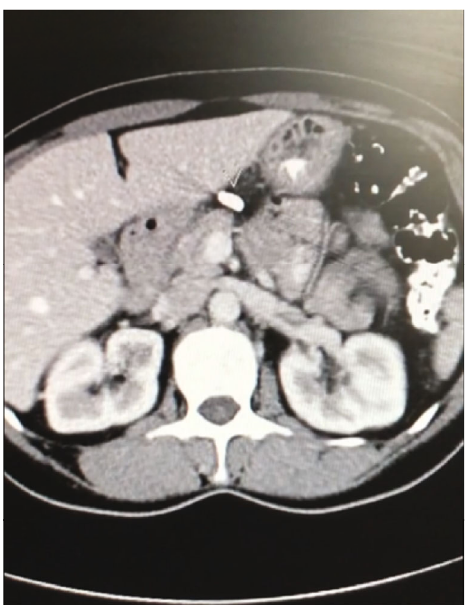
Figure 1: Transverse section of a computed tomography scan of the abdomen showing a migrated Filshie clip lying inferior to the left of the liver.